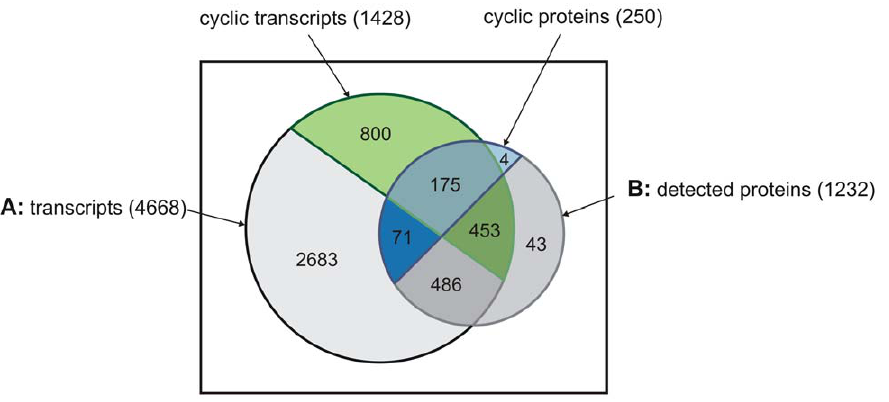
Figure 3. Venn diagram representing all transcripts and proteins with and without oscillating abundance profiles during a diurnal cycle. (A) Transcripts present on the microarray and (B) proteins detected under diurnal conditions. Transcripts identified as cyclic are shaded in green , while proteins identified as cyclic are in blue .